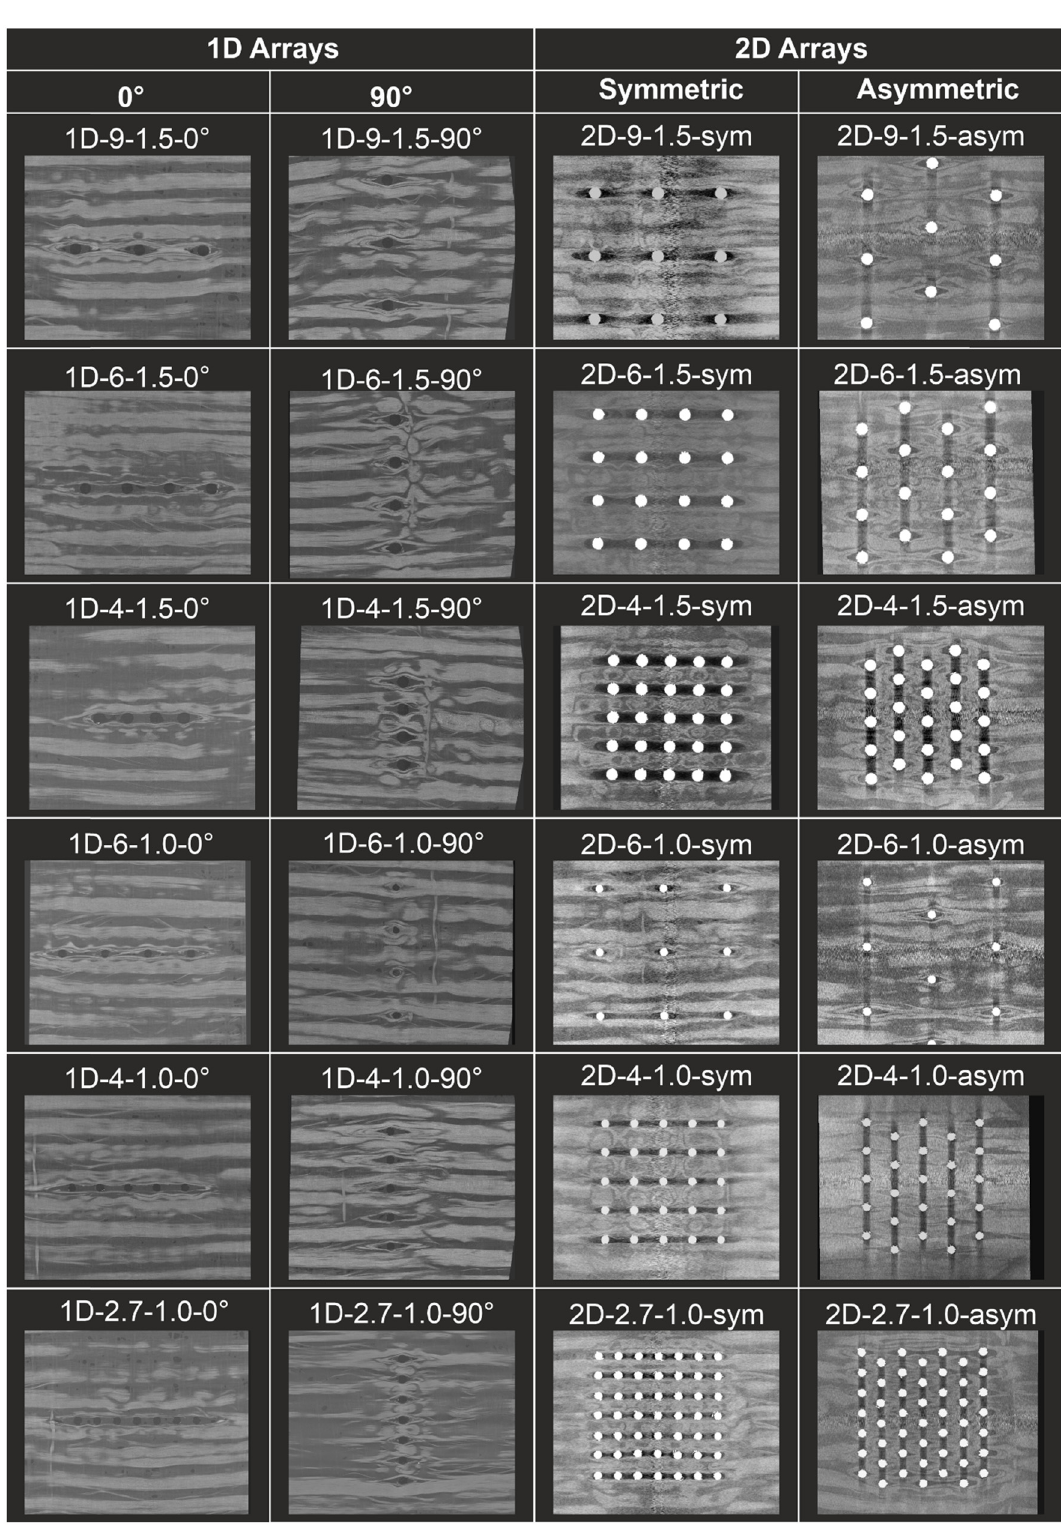
Figure 6: Summary of CT - image in the X / Y